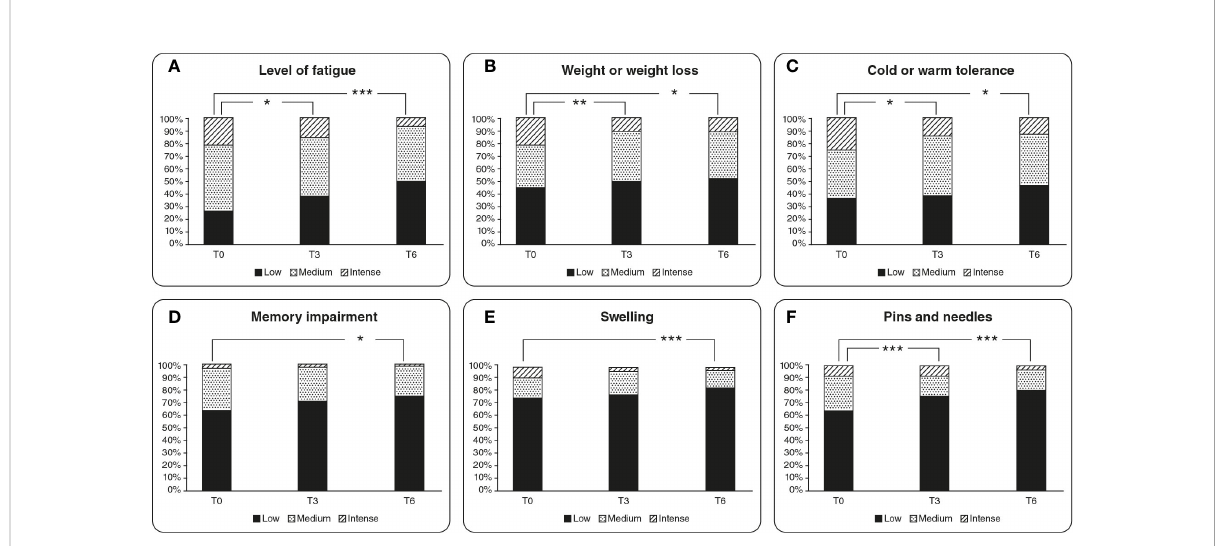
FIGURE 3 Graphical representation ofresults retrieved fromthe questionnaires regarding the quality oflifeof the patients. The graphs arereferred to both 3 monthsand 6 months timepoints considered in the study, representinglow, medium, and high perceptionof the sensation. (A) Level offatigue trend over the treatment period, (B) changes in weight perception, (C) coldor warmtolerance, (D) memoryimpairment experienced, (E) swellingsensation over the 6 months oftreatment, (F) sensationof pins and needles. * = p value < 0.05, **= p value < 0.01, *** = p value